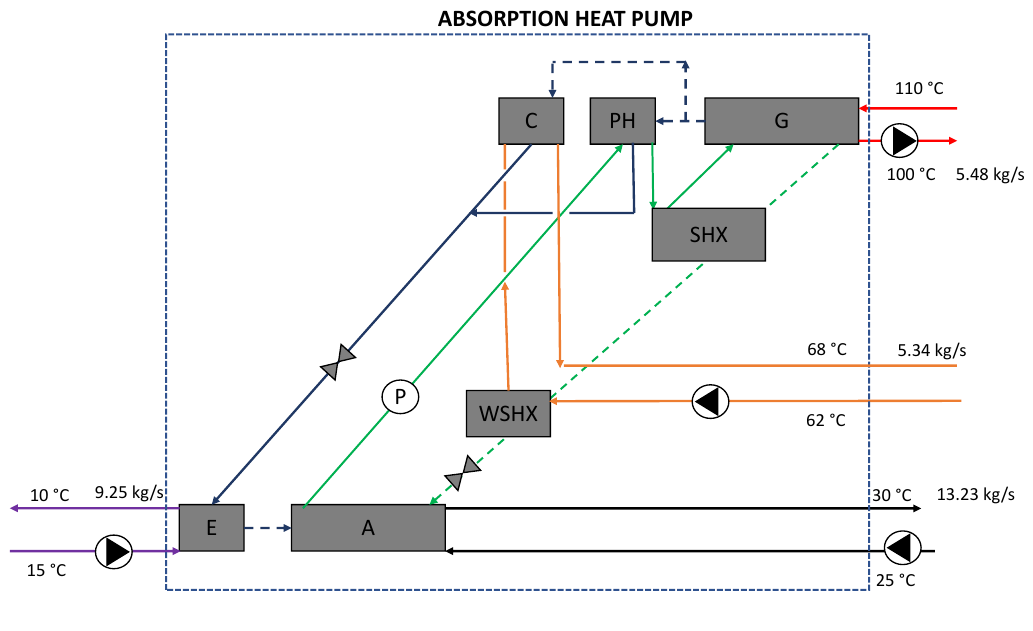
Figure 16. Working temperatures and flow rates for the simultaneous heating and cooling for air conditioning applications. Table 7. Absorption heat pump performance for cooling and water